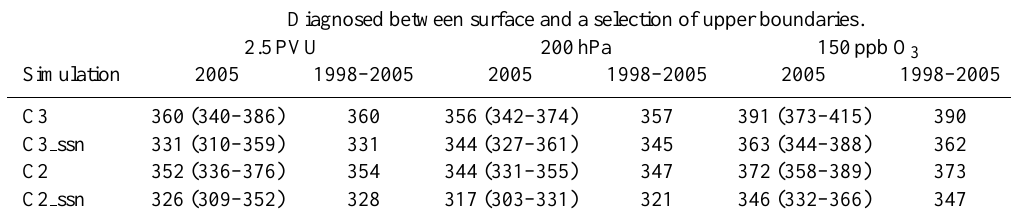
Table 5. Modelled annual average O 3 burden [Tg(O 3 )] for different definitions of tropospheric domains. Diagnosed between surface and a selection of upper